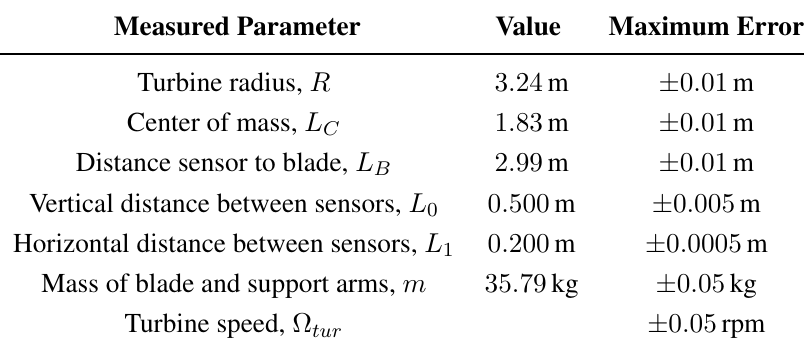
Figure 3. Length and force notations of the load cell assembly. Note that τ bending around the tangential unit vector ˆ t . Table 1. Turbine parameters and estimated maximum